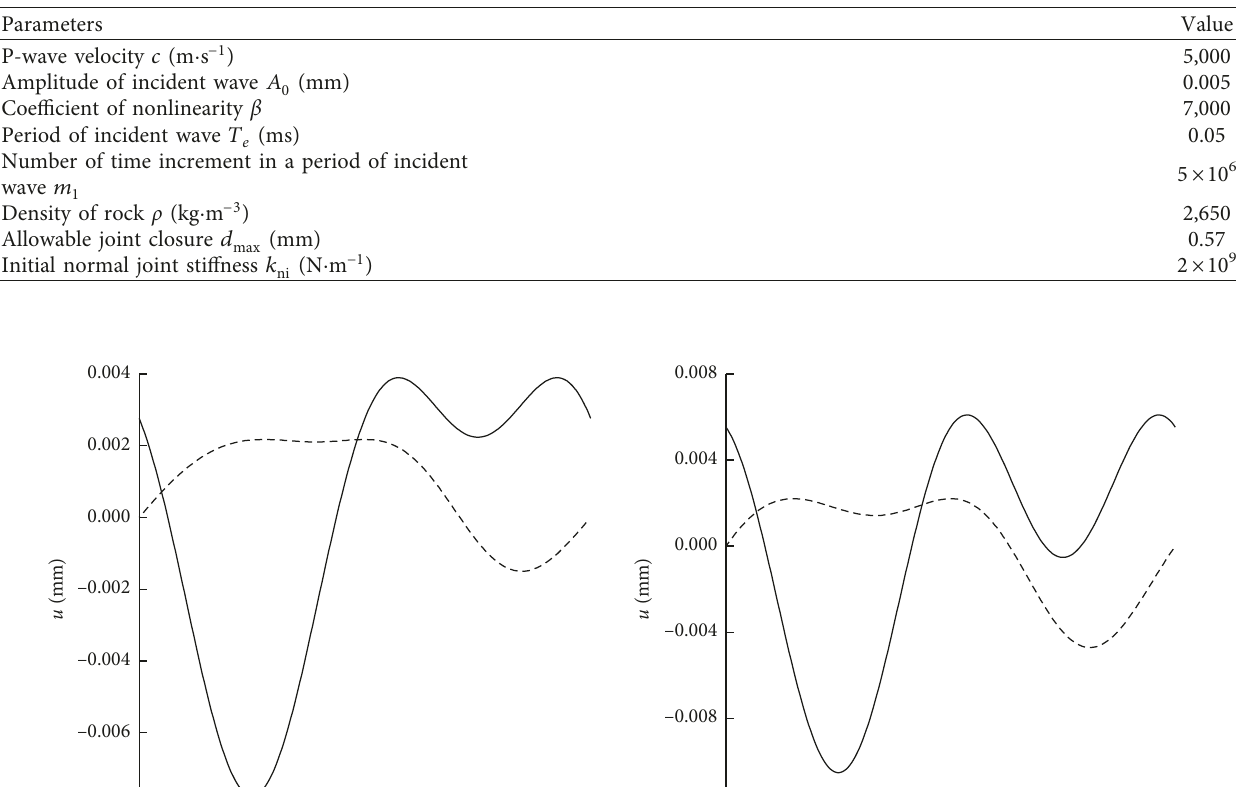
Table 1: Material properties of the incident wave and the rock joint used for numerical